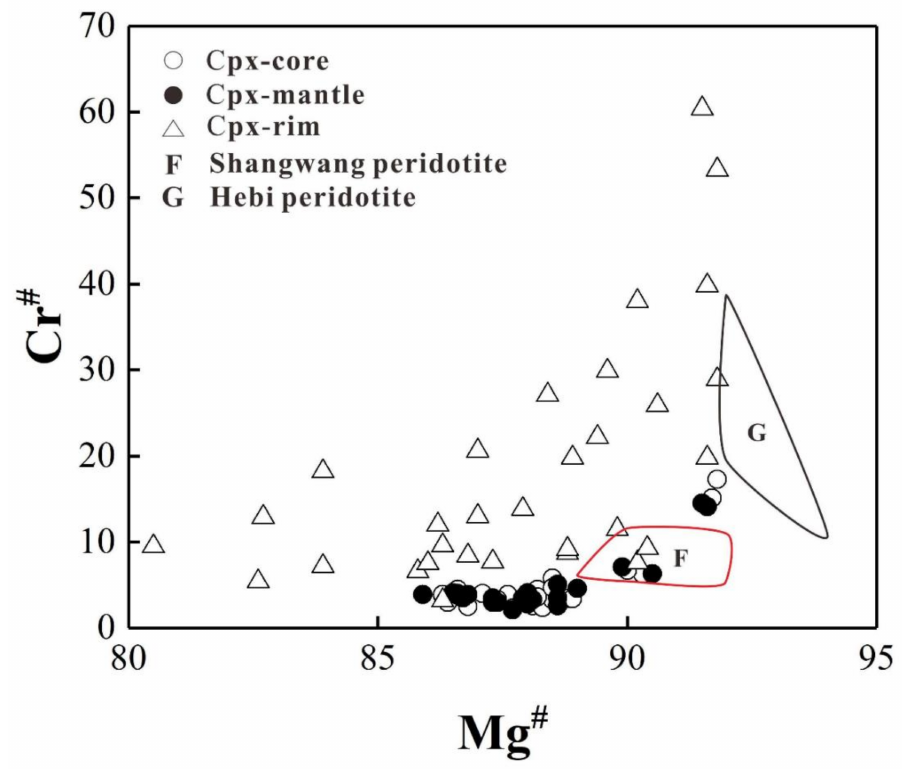
Figure 10. Plots of Mg # -Cr # for the clinopyroxene (Cpx) in the websterite. Note: The data of Shanwang and Hebi peridotite are the same as Figure